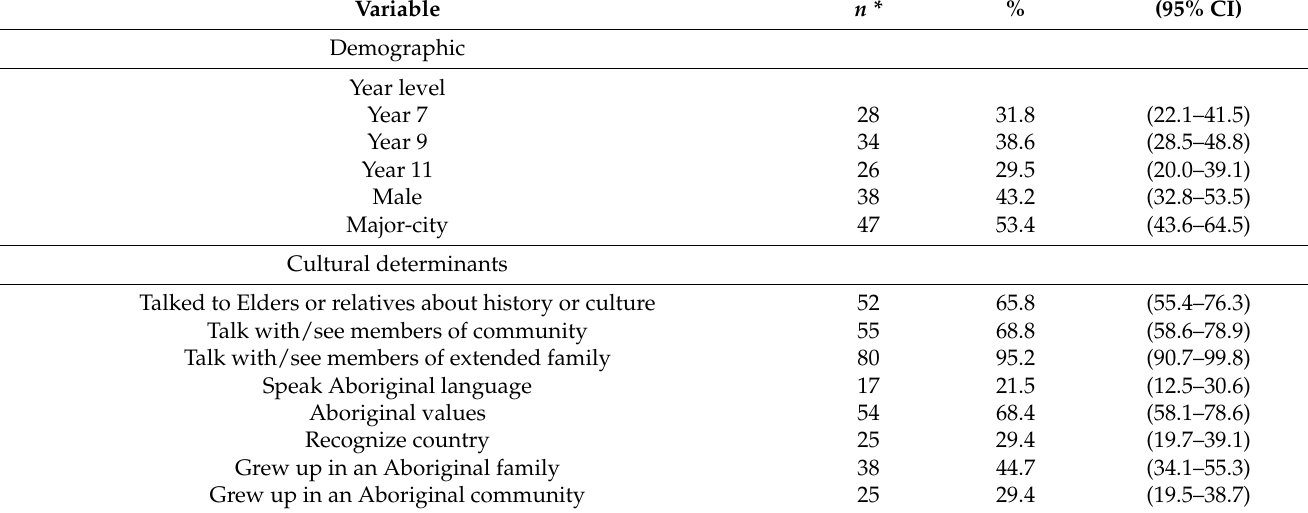
Table 1. Frequency of demographic, structural, and cultural characteristic identified by the collaborative ( n =